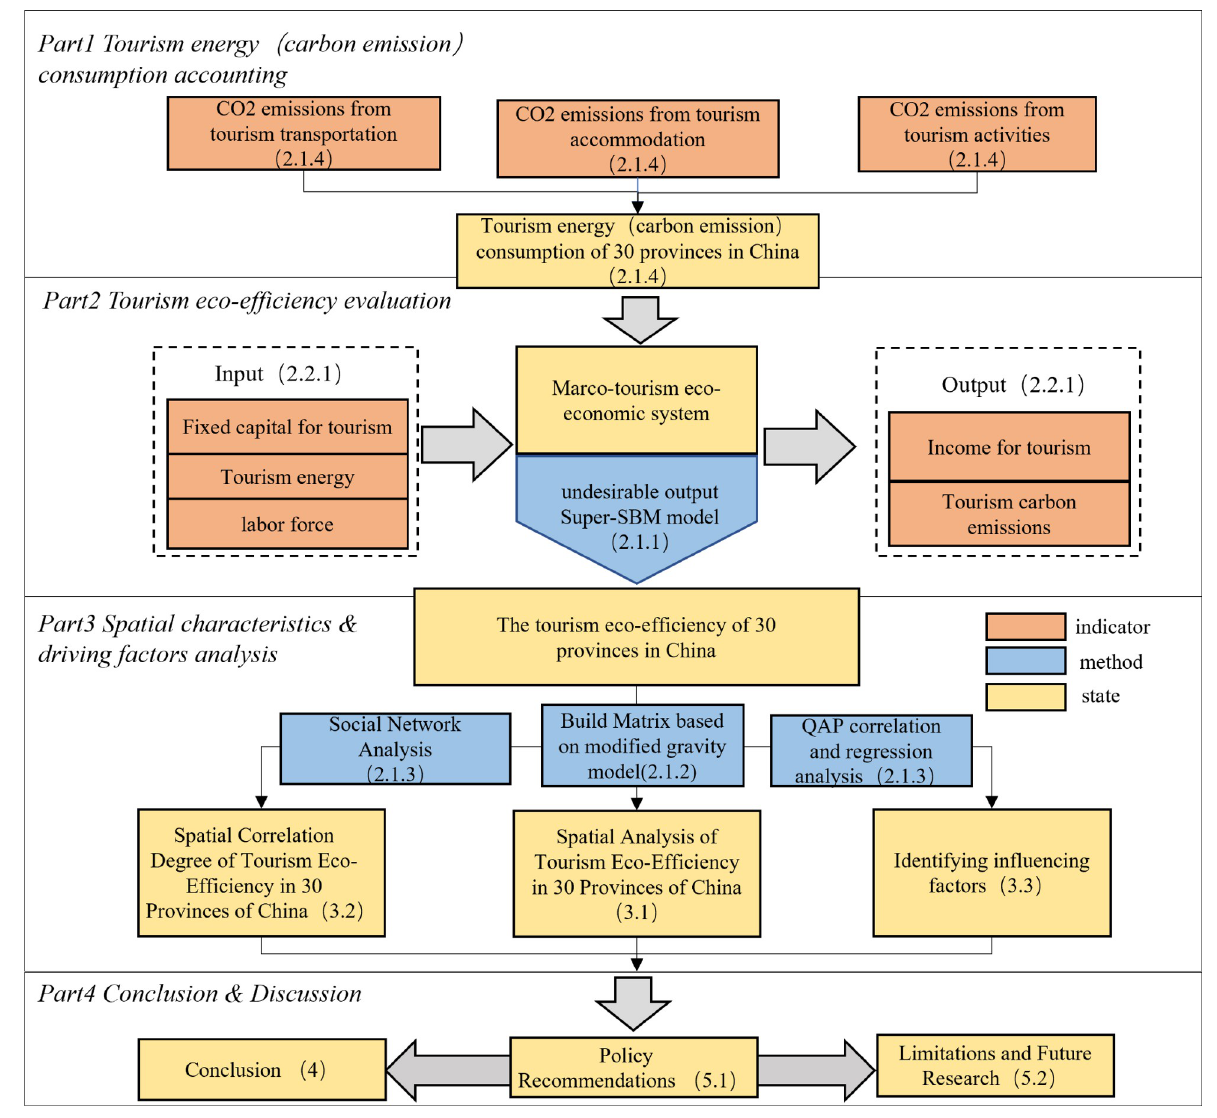
Fig 1. The technical route applied for China’s provincial tourism eco-efficiency